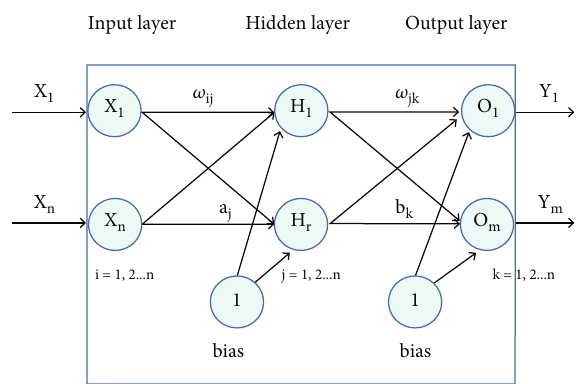
Figure 10: Schematic of BP neural network structure.